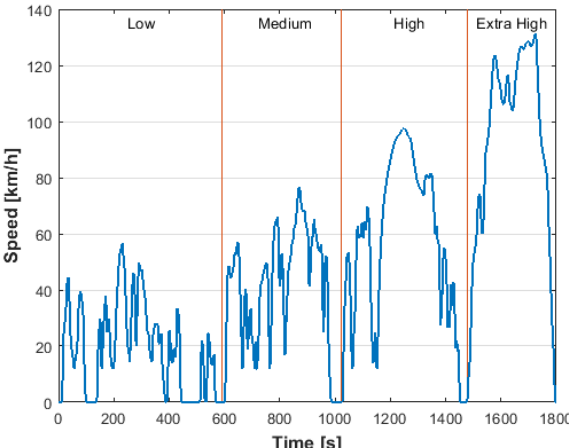
Figure 7. The Worldwide Harmonized Light Vehicles Test Cycle (WLTC) drive cycle for Class 3b vehicles used to estimate the energy consumption [13].